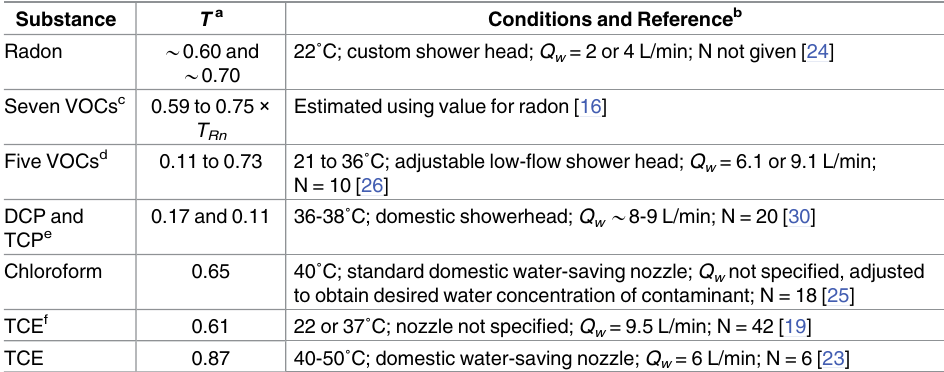
Table 4. Selected TransferEfficiencies ( T ) for Volatile Chemicals in Showers. Substance